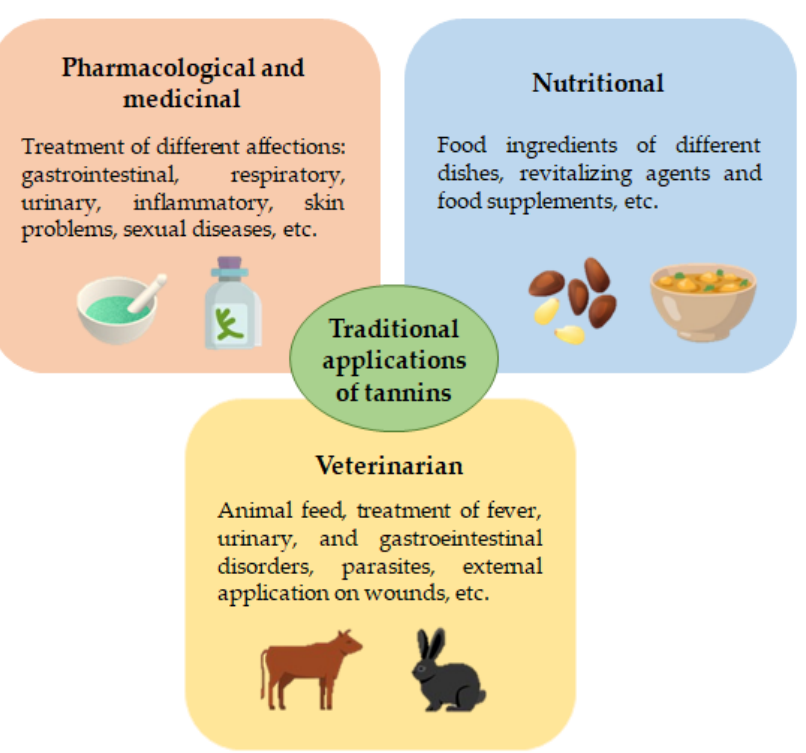
Figure 2. Brief description of the traditional uses of tannins with pharmacological, medicinal, nutritional, and veterinarian applications.